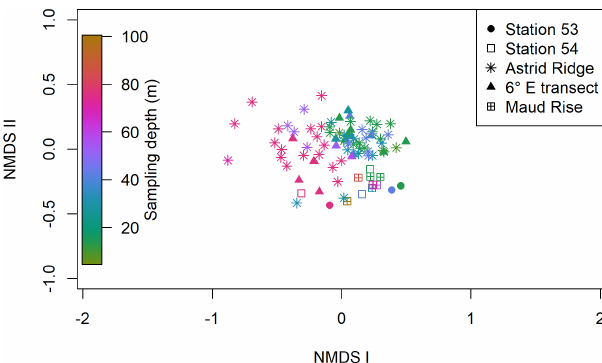
Figure 6. Results of the NMDS clustering of the microscopy count samples. The color shows the sampling depth, and the different sam- pling areas are shown with different symbols; see the legend. The stress value of the plot is 22%.